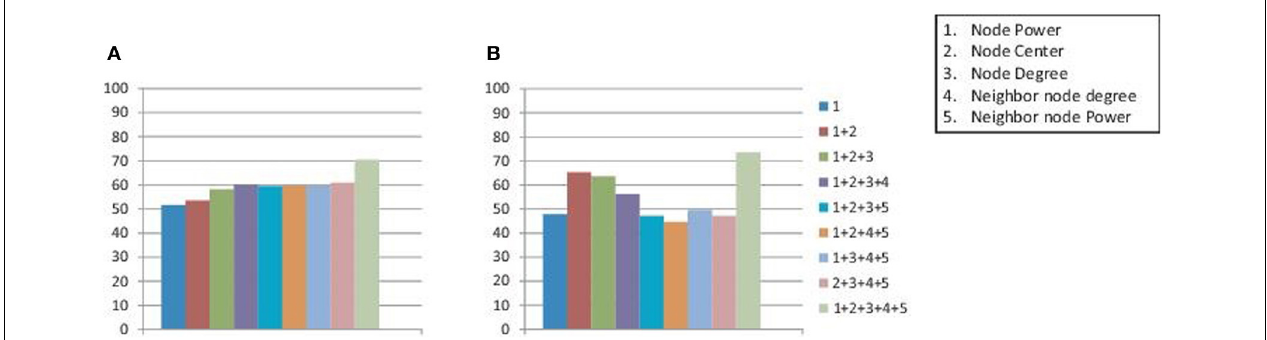
FIGURE 4 | Figure plots the average detection accuracies on all the data centers when inter-graph distances are calculated using different subsets of node attributes. The classification is